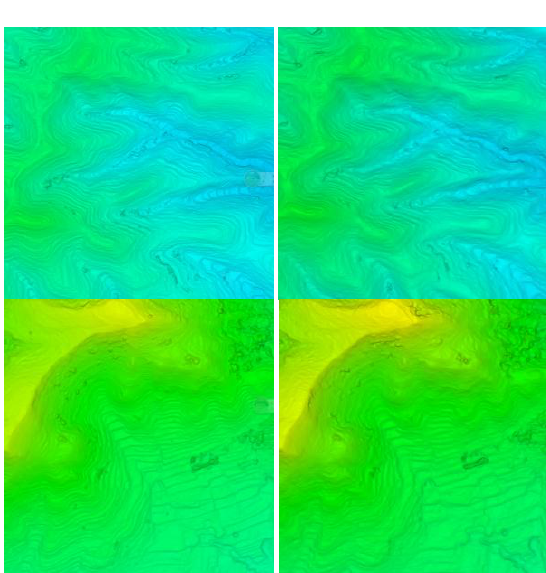
Figure 7. Details comparison between shaded Wordview-2 DSM (left) and simulated GF-7 DSM